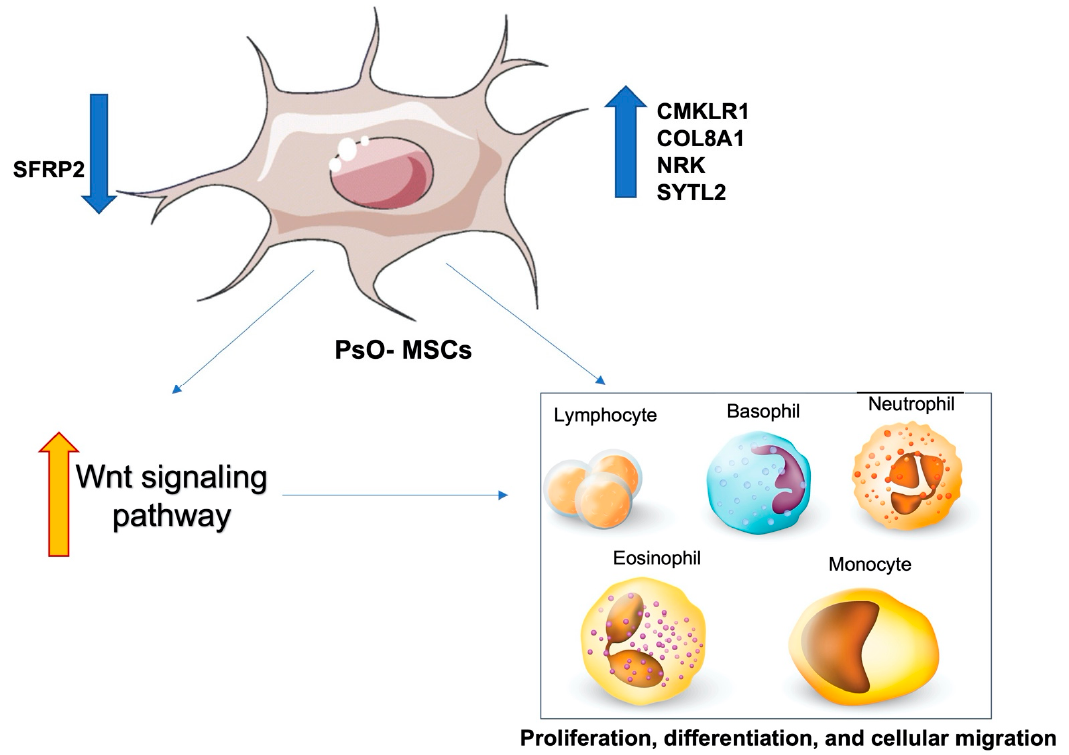
Figure 4. Relationships between PsO-MSCs and immune cells: overexpression of CMKLR1, COL8A1, NRK, and SYTL2 in PsO-MSCs promotes proliferation, differentiation, and migration of healthy peripheral blood mononuclear cells (PBMCs), including lymphocytes, basophils, neutrophils, eosinophils ad monocytes, through the activation of Wnt signaling pathway.